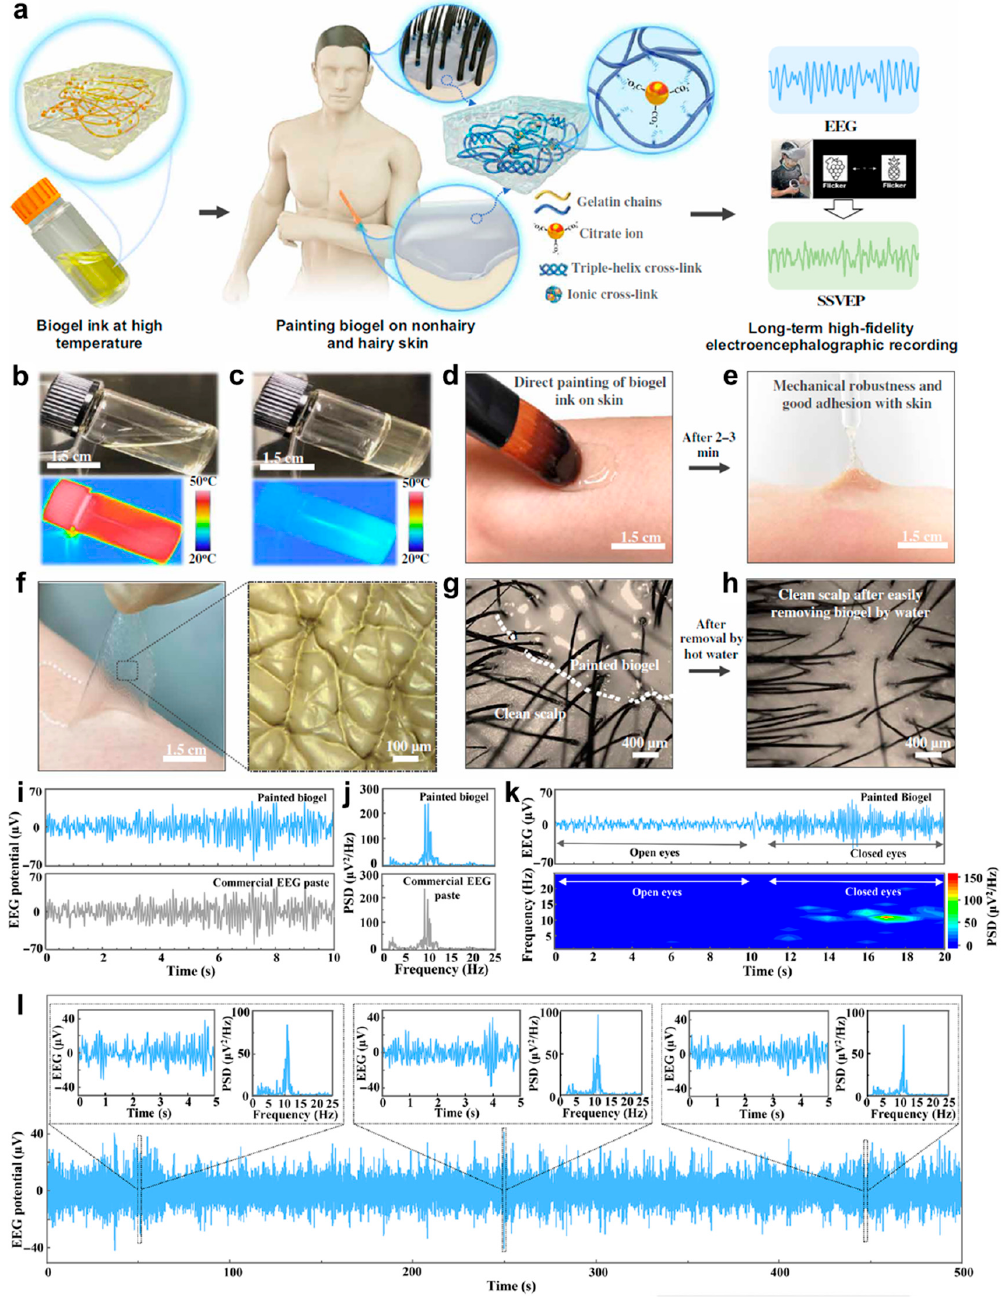
Figure 5. Concept illustration, performances characterization and application of gelatin-based biogel. ( a ) Conceptual graph of paintable biogel on hairy scalp for EEG monitoring. ( b ) Photograph of liquid biogel at high temperature. ( c ) Photograph of solid biogel at room temperature. ( d ) Photograph showing liquid biogel painted on skin directly. ( e ) Photograph of gelation and adhesion on skin for biogel at room temperature after 2–3 min. ( f ) Photograph (left) and optical image (right) of biogel peeled off from skin. ( g ) Optical image of hairy scalp coated by biogel. ( h ) Optical image of hairy scalp after removing biogel by hot water. ( i ) EEG signals acquired by commercial EEG paste (bottom) and gelatin-based biogel (top). ( j ) PSDA for EEG signals from ( i ). ( k ) EEG signals and corresponding spectrogram under opening eyes/closing eyes. ( l ) 500 s of EEG signals recorded by gelatin-based biogel. Insets illustrates partially enlarged images and the corresponding PSDA [131].